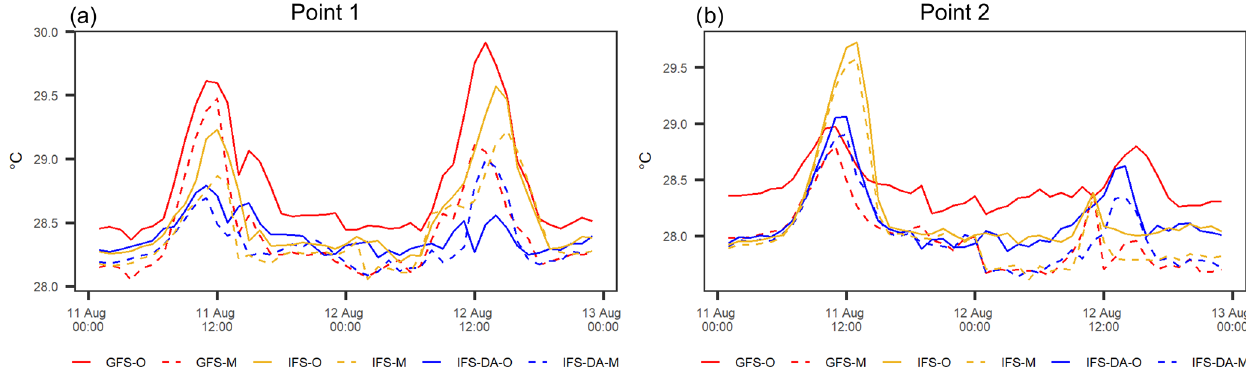
Figure 5. Case study 1: temporal evolution of SSTSK ( ◦ C) at points 1 and 2, as shown in Fig. 3b.